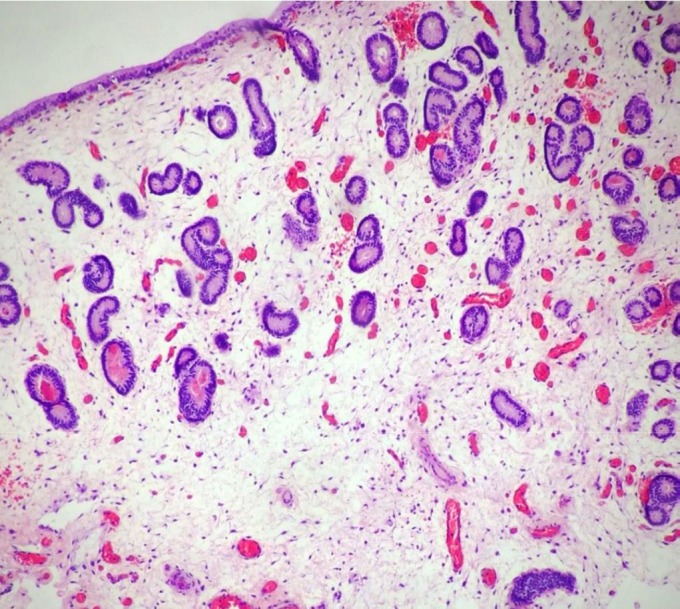
Gynecological examination in Pantaneiro mares. Endometrial biopsy in mare 6 shows intense edema. Hematoxylin-eosin, 10×.